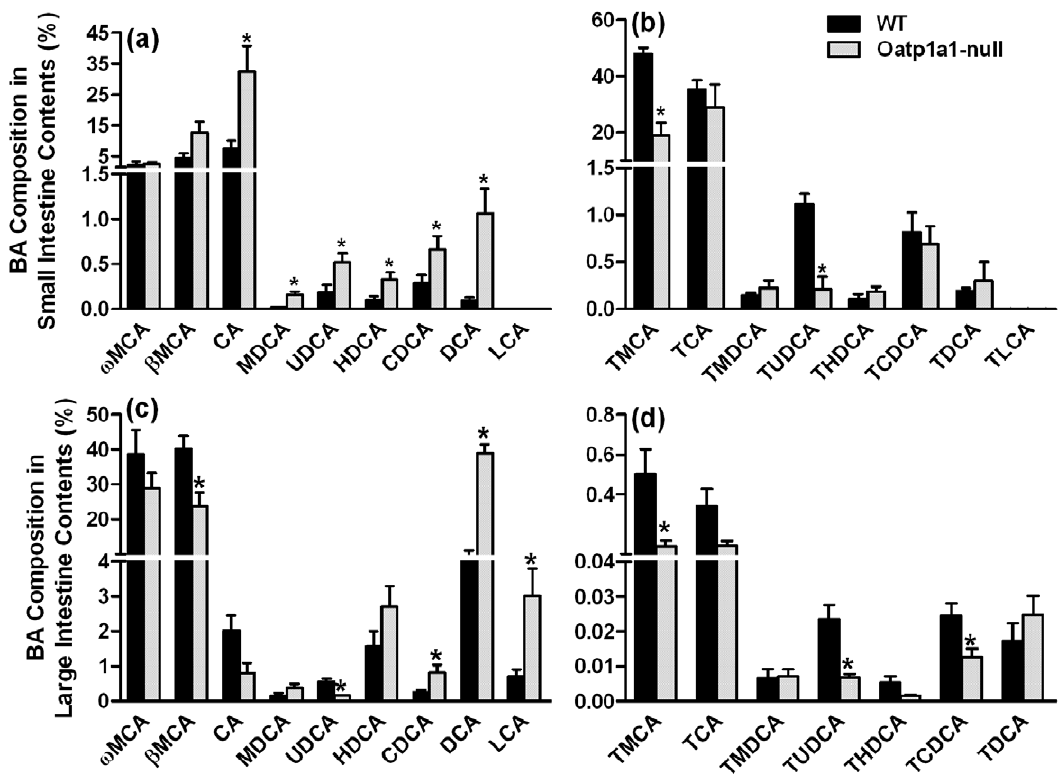
Figure 4. BA composition in the small (a and b) and large (c and d) intestinal contents of mice. BA concentrations in the intestinal contents of male WT and Oatp1a1-null mice (n=5/group) were analyzed using ultra performance liquid chromatography-tandem mass spectrometry (UPLC-MS/MS). All data are expressed as mean 6 S.E. for five mice in each group. *, statistically significant difference between WT and Oatp1a1-null mice ( p , 0.05).